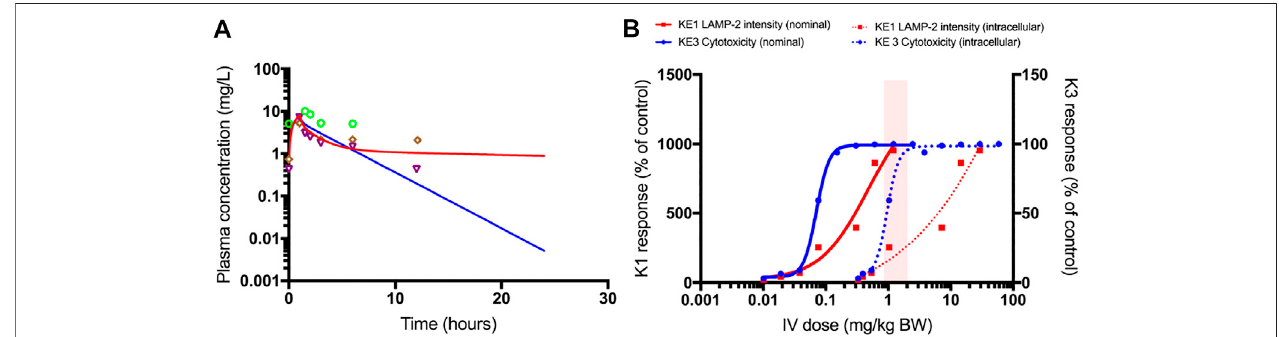
FIGURE 9 | PBPK-model simulated plasma concentrations of 1.0 mg/kg bodyweight polymyxin B, administered by intravenous infusion over 1 h in humans (A) . The blue line is the simulation without transporter kinetics (assuming only glomerular fi ltration). The red line includes active transport to proximal tubule cells. Separate points are measured plasma concentrations obtained from three female patients (Zavascki et al., 2008). QIVIVE based on nominal (solid lines) and cell-associated (dashed lines) polymyxin B in vitro effect concentrations (B) . The red lines are human bioequivalent dose-response relationships for polymyxin B using results from the in vitro LAMP-2 assay in RPTEC/TERT1 cells, the blue lines are human bioequivalent dose-response relationships using results from the in vitro CellTiter-Glo ® assay with RPTEC/TERT1 cells. The pink bar highlights the clinical authorized dose of polymyxin B, which is associated with nephrotoxic side effects in patients. Note that biological effects on both KEs kick in at similar concentrations, whereas the dose-response concordance between both KE appears to be poorer at higher concentrations at which pronounced cytotoxicity is recorded. This may be due to disruption of lysosomes at these concentrations and time-points. A better concordancebetweenbothKEsmaybeexpectedwhenintegratingtheaspectoftime,i.e.assessingLAMPexpressionatanearliertime-pointatwhichcytotoxicitydoes not yet